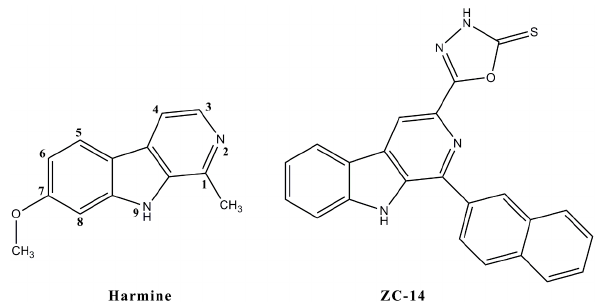
Figure 1. Chemical structure of harmine and its derivative, ZC-14.